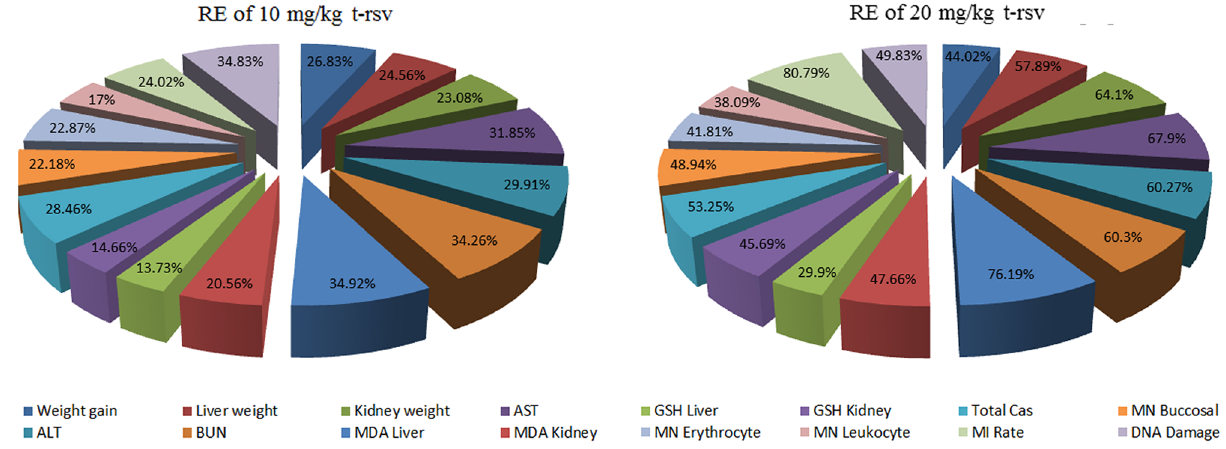
Figure 11. Recovery effects of 10 mg/kg and 20 mg/kg t-rsv on all